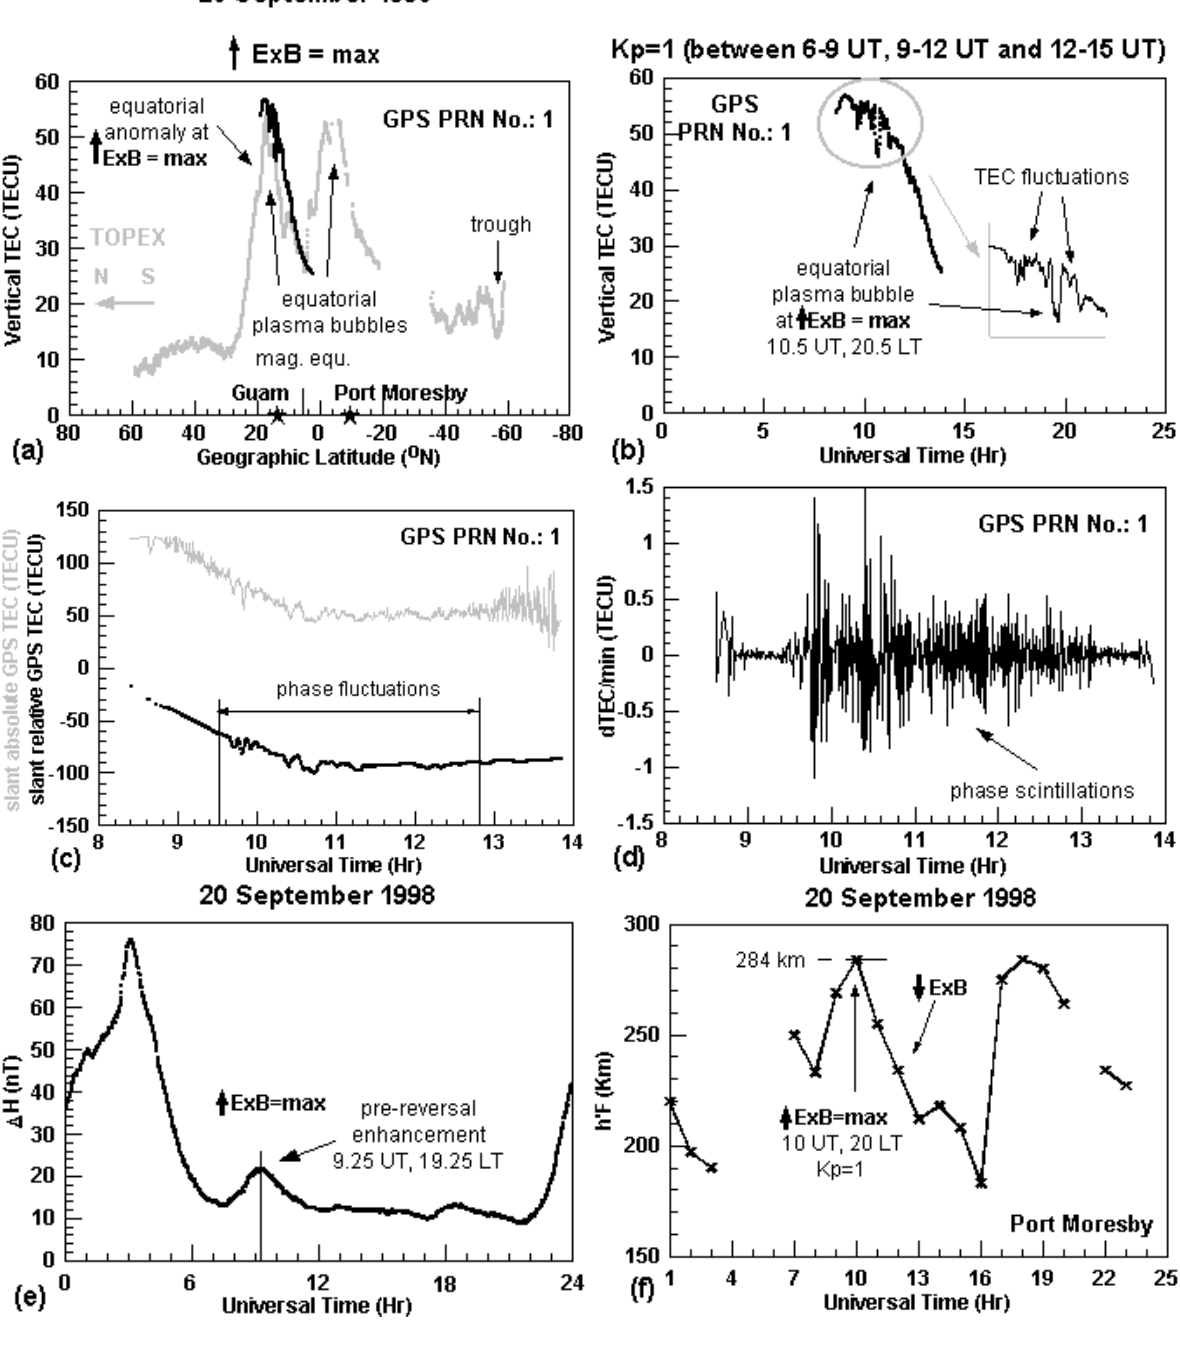
Fig. 3. The Guam GPS data show equatorial plasma bubbles (a) with the matching TOPEX TEC curve in latitudes (at 157 ◦ E, LT=20.20h at the magnetic equator in decimal hours) and (b) in time. (c) Signal degradation on the raw GPS TEC data is due to the GPS phase scintillation. (d) The filtered dTEC/min plot shows the intensity of that phase scintillation. (e) The 1 H data plot obtained with the Muntinlupa and Lumping magnetic data shows the time of pre-reversal strengthening at 121 ◦ E geographic longitude, in the Australian region. (f) The data from Port Moresby show the sudden increase in height due to the pre-reversal strengthening, and then the sudden decrease due to the reversal and downward drift. The GPS satellite is distinguished by the PRN (Pseudo Random Noise) number. In the Australian region